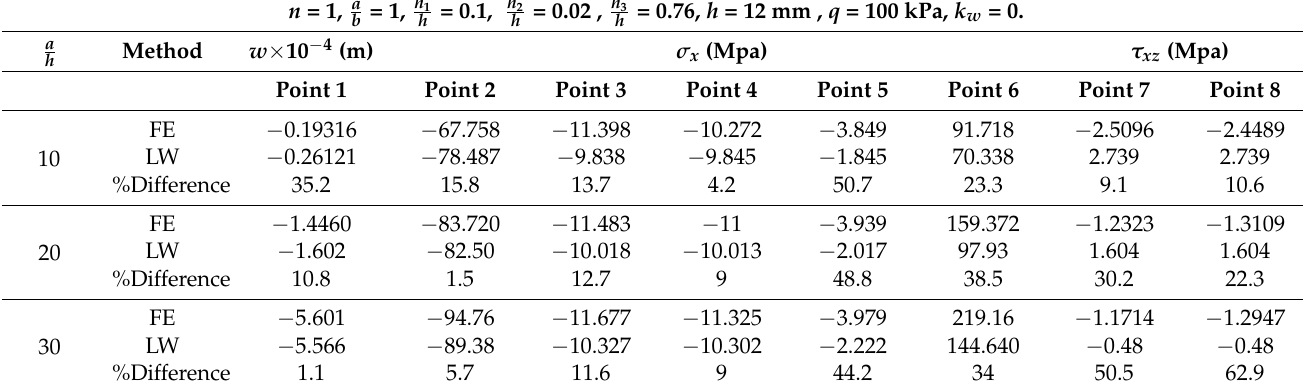
Table 9. Comparison of the result based on LT and those FE findings.